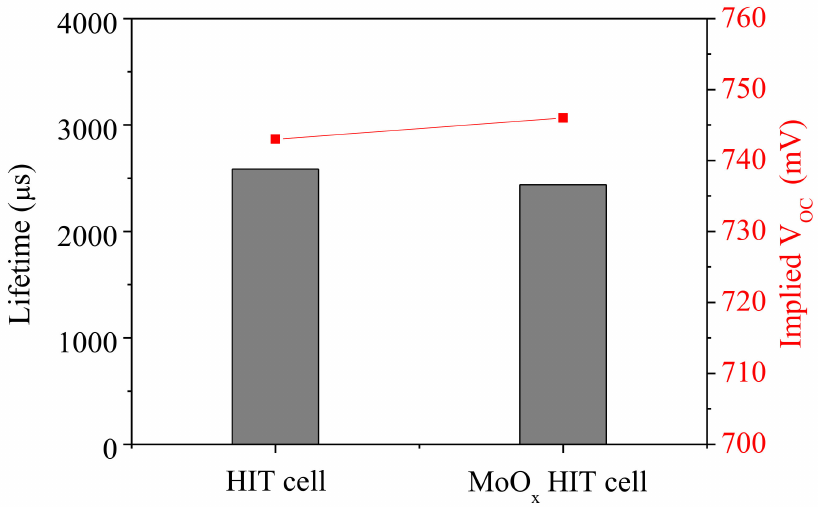
Figure 5. Change of effective carrier lifetime and implied V OC before and after MoO X application to HIT cell. Reproduced with permission from Reference [45].